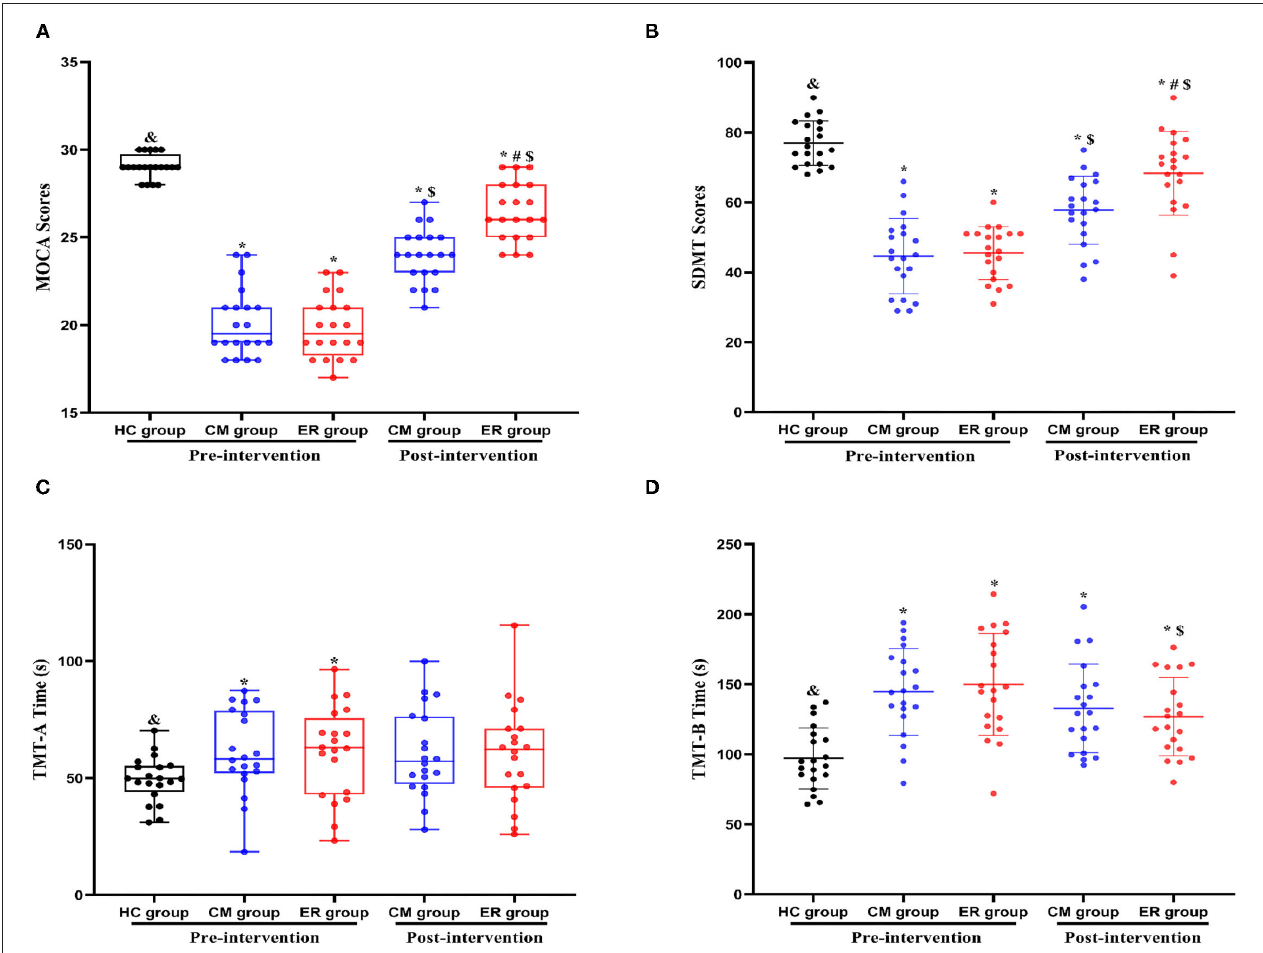
FIGURE 2 | Indexes of cognitive function in each group pre-intervention and post-intervention. *Compared with the HC group, p < 0.05. & Compared with the CM group pre-intervention, p < 0.05. # Compared with the CM group post-intervention, p < 0.05. $ Compared with the same group pre-intervention, p < 0.05. HC, healthy control; CM, conventional medical treatment; ER, enriched rehabilitation treatment; MoCA, Montreal Cognitive Assessment; SDMT, Symbol Digit Modalities Test; TMT-A, Trail Making Test part A; TMT-B, Trail Making Test part B. (A) The scores of MOCA test pre-intervention and post-intervention; (B) the scores of SDMT test pre-intervention and post-intervention; (C) the time consumption of TMT-A pre-intervention and post-intervention; (D) the time consumption of TMT-B pre-intervention and